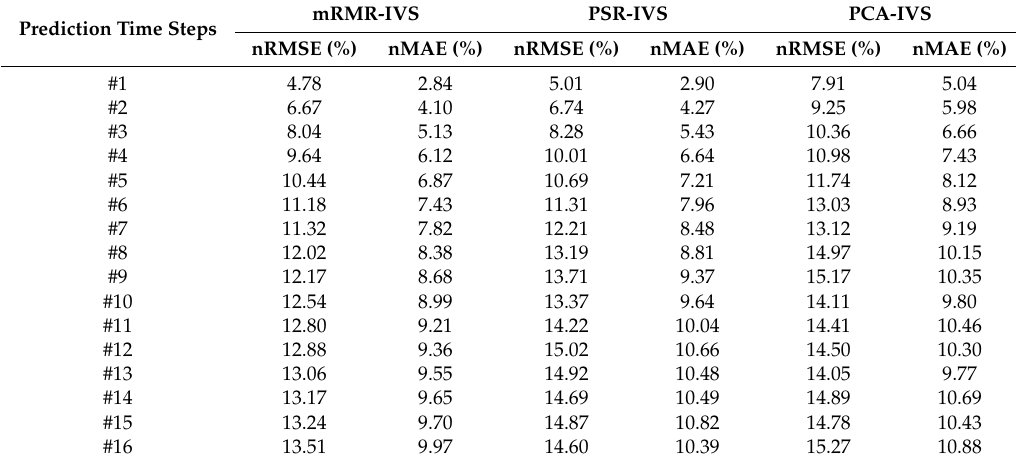
Figure 8. Error trend in different prediction steps of Xuqiao farm: ( a ) nRMSE of test month; and ( b ) nMAE of test month. Table 4. Comparison of the multi-step ahead prediction performance of Anzishan farm.